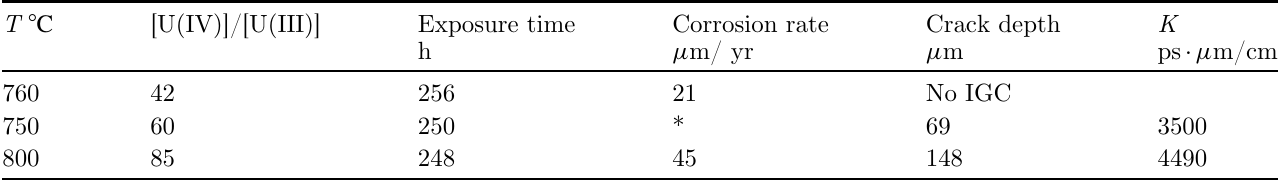
Table 4. Corrosion resistance of the Hastelloy-N alloy in the fuel 71LiF-27BeF metal vs. temperature ( T ) and [U(IV)] / [U(III)] ratio. T °